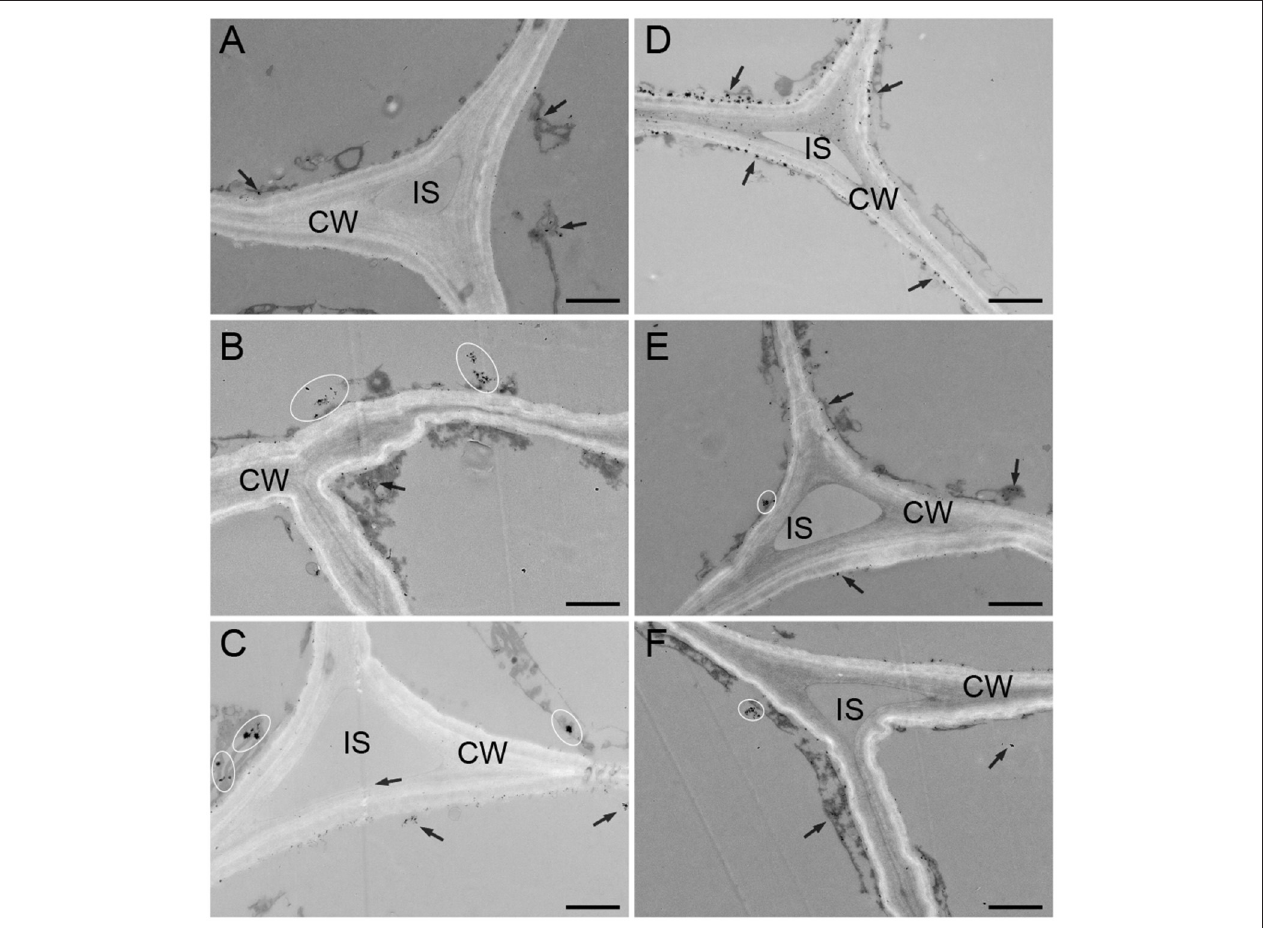
FIGURE 3 | The localization of calcium antimony precipitates in “Dongnong 690” hypocotyl cells at 24h under different conditions. (A–F) stand for treat with dark, white light, blue light, blue light + 3mM CaCl 2 , blue light + 1mM LaCl 3, and blue light + 1mM neomycin, respectively. bar = 1 µ m. Arrows and ovals indicate precipitates of calcium. CW: cell wall. IS: intercellular space.